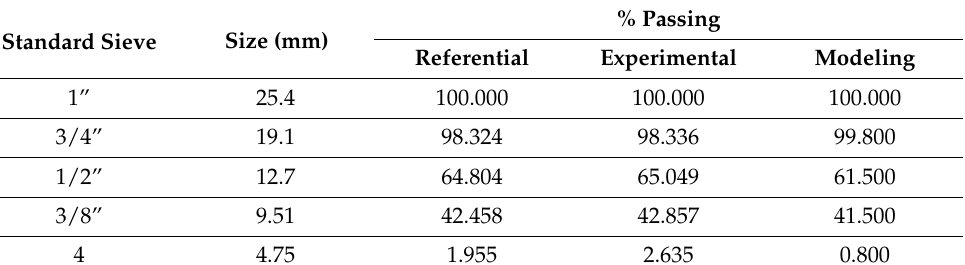
Table 7. Data of gradations used.